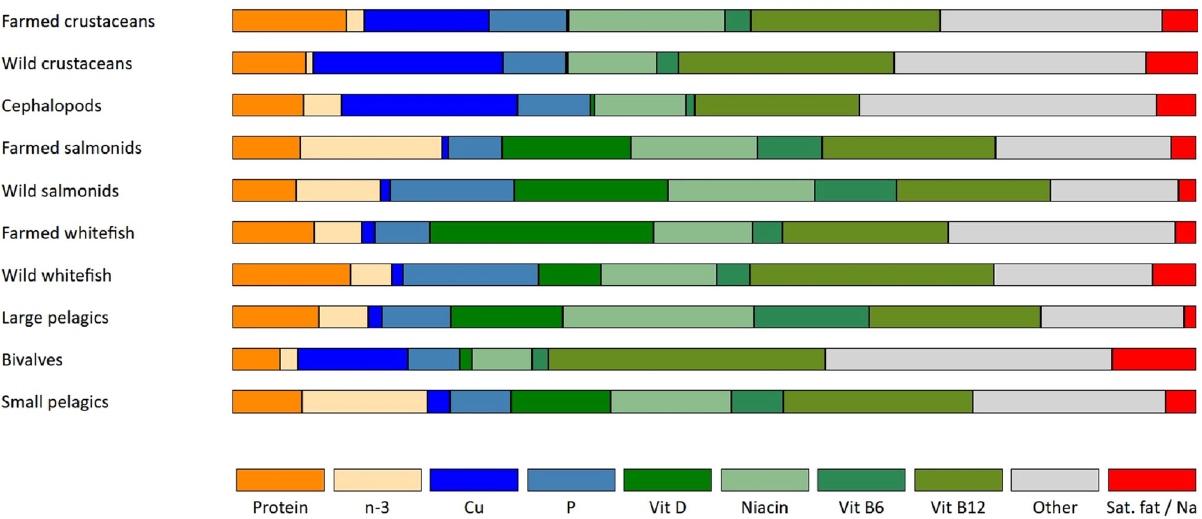
Fig. 3 Contribution of nutrients to nutrient density for seafood groups. Nutrient pro fi les of seafood groups expressed as percentage contribution to the nutrient density score NDS 21 , calculated as weighted averages of included species within groups based on edible production volumes. Desirable nutrients are visualized if contributing ≥ 10% of nutrient density for at least one group. Other includes all remaining desirable nutrients not reaching the cutoff